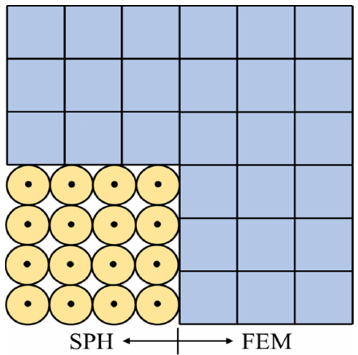
Figure 2. The coupling of SPH and FEM (reproduced with minor changes from Koneshwaran et al. [90], with permission from Copyright Clearance Center, Inc. (CCC) on behalf of Elsevier Science & Technology